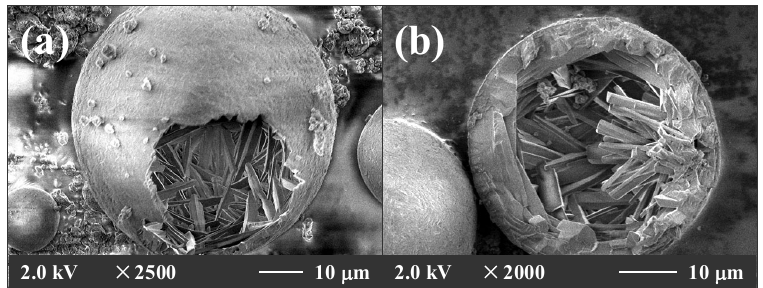
The particles containing crystallized mannitol were observed by SEM as shown in Figure